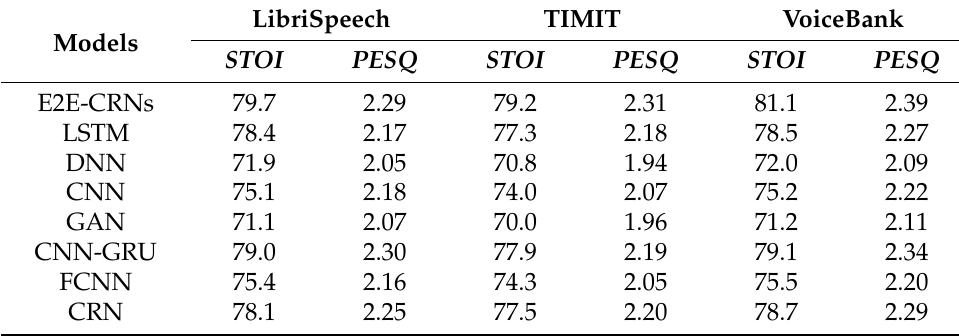
Table 9. Cross Corpus Analysis of STOI and PESQ